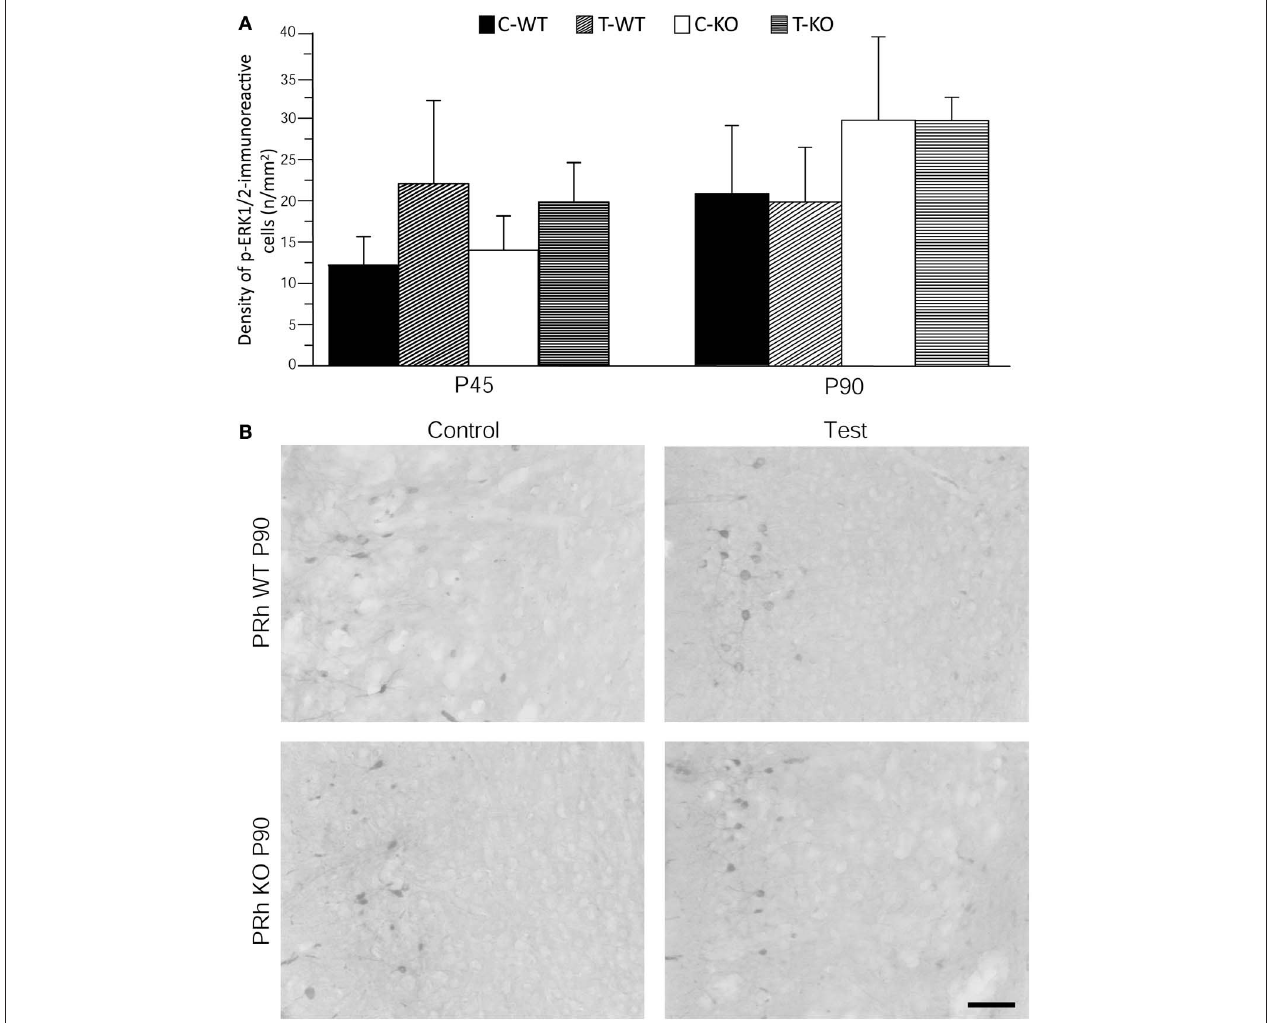
FIGURE 5 | Immunostaining of p-ERK1/2 in perirhinal cortex (PRh) after exposure to the test for audiogenic seizure induction and in relation with the mouse genotype (WT vs. Fmr1 KO) and the age (P45 and P90). (A) Bar graphs of cellular density based on counts of p-ERK1/2-immunopositive cell nuclei per mm 2 in PRh. (B)